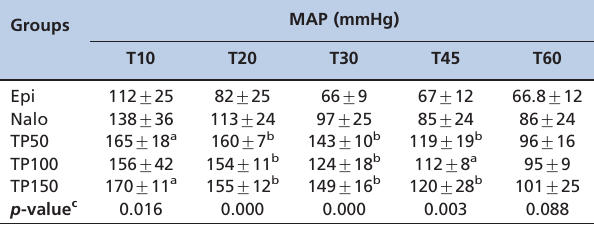
Table 5 - Base excess: comparisons of the groups vs. time Groups